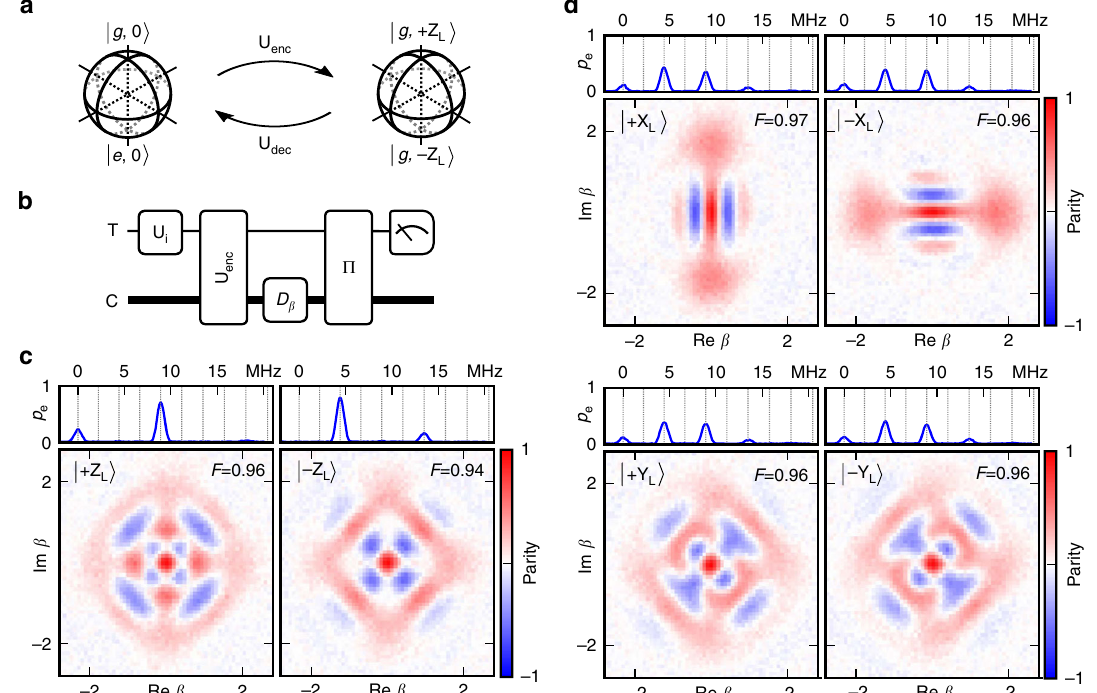
Fig. 2 Characterization of encoded states. a U enc and U dec are operations that coherently map between two distinct two-dimensional subspaces, represented by Bloch spheres. The fi rst subspace consists of the transmon g j i and e j i levels, with the oscillator in the vacuum. The second is given by the oscillator-encoded states þ Z L j i and (cid:2) Z L j i (Eq. (1)), with the transmon in the ground state. b Wigner tomography sequence that characterizes the encoded states. A transmon state is prepared by applying an initial rotation U i and is mapped to the oscillator using U enc . An oscillator displacement D β followed by